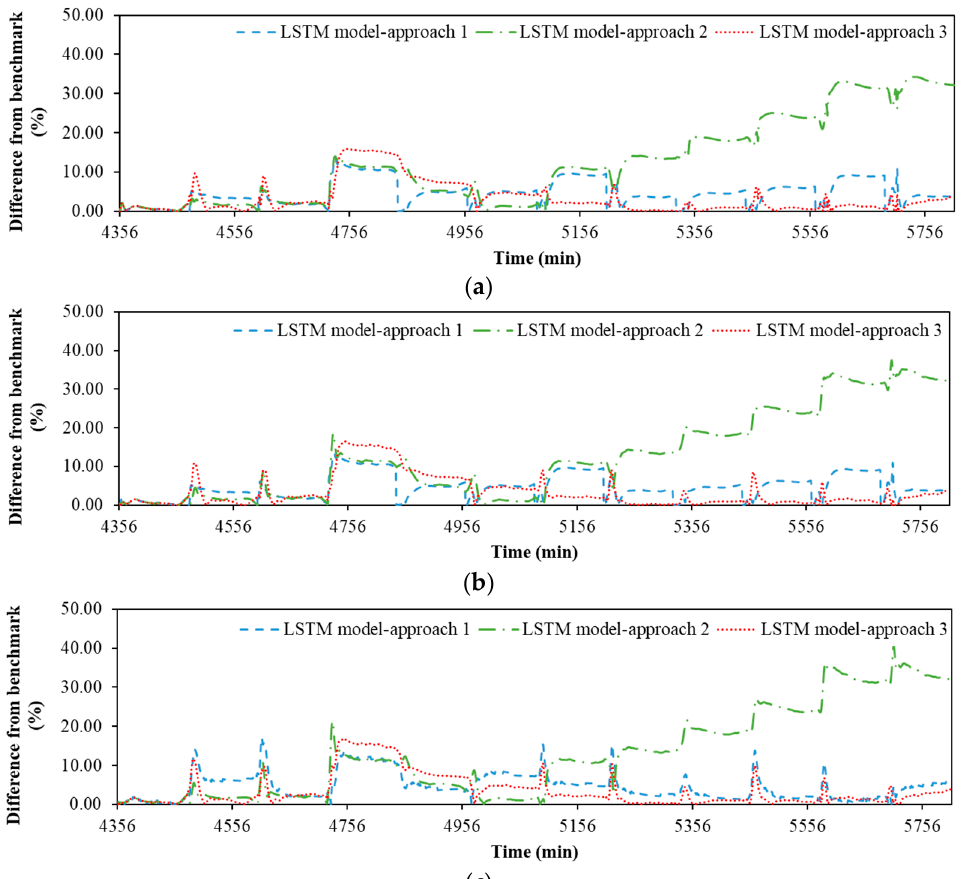
Figure 13. Differences of groundwater levels using the three approaches of employing the LSTM model from the groundwater level using the prescribed pumping policies (benchmark) at ( a ) point P 1 , ( b ) point P 2 , and ( c ) point P 3.